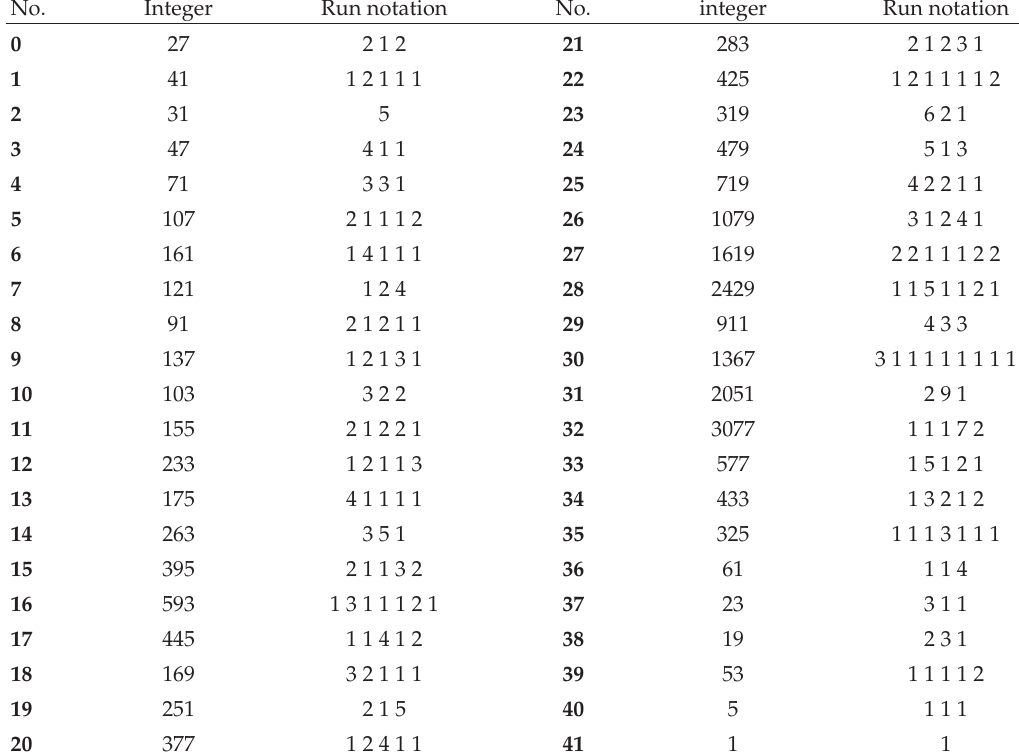
Table 1: 3 x (cid:2) 1 path (cid:3) odd integers (cid:4) for n (cid:5) 27 expressed in integer and run